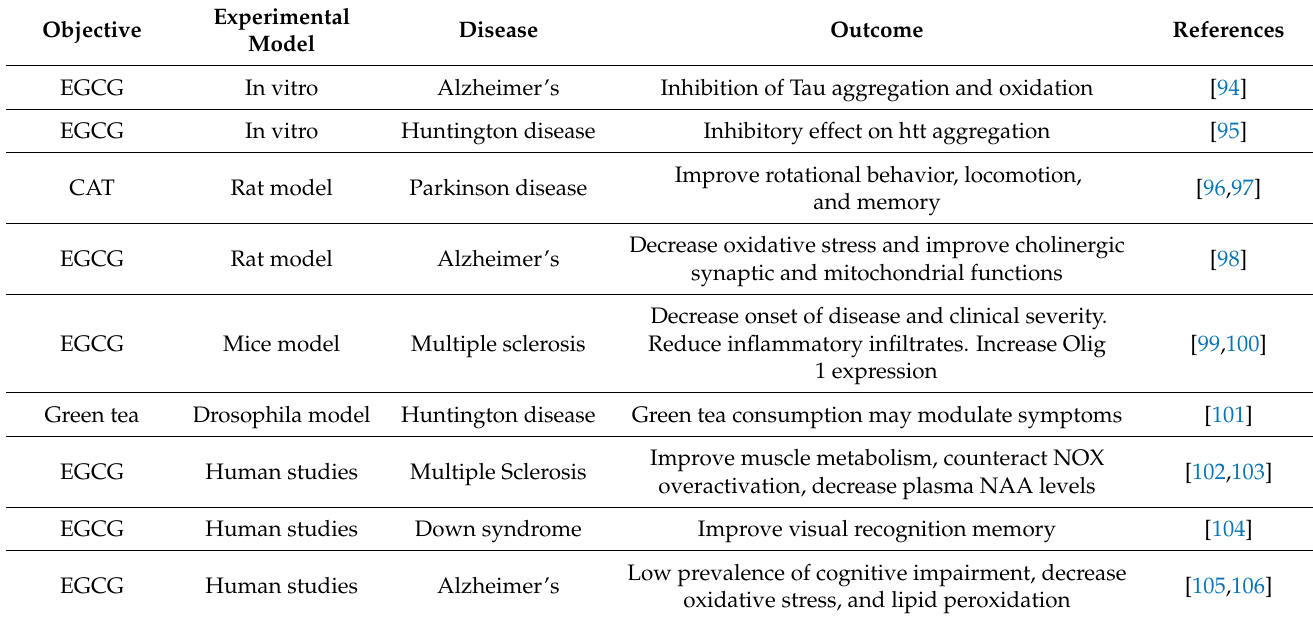
Table 1. Neuroprotective effect of catechins in various neurodegenerative